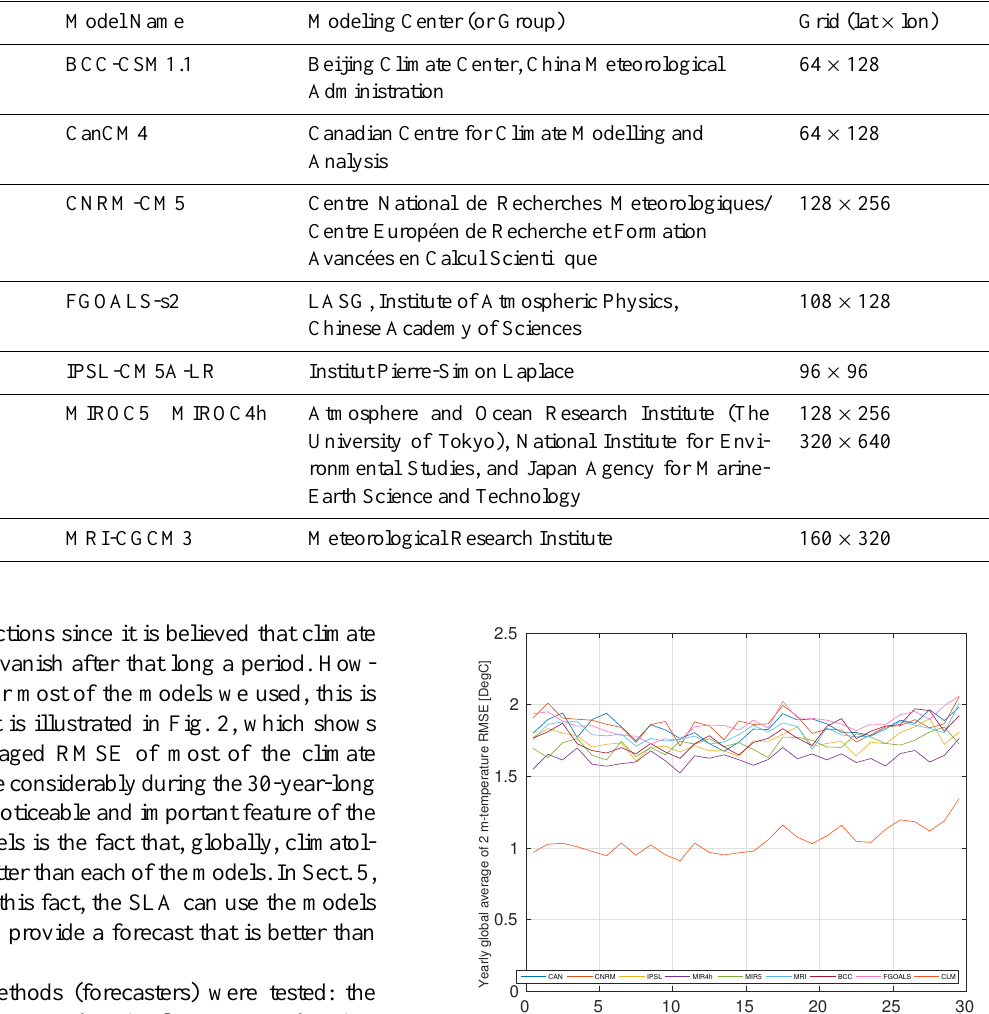
Table 1. Model Availabilities.